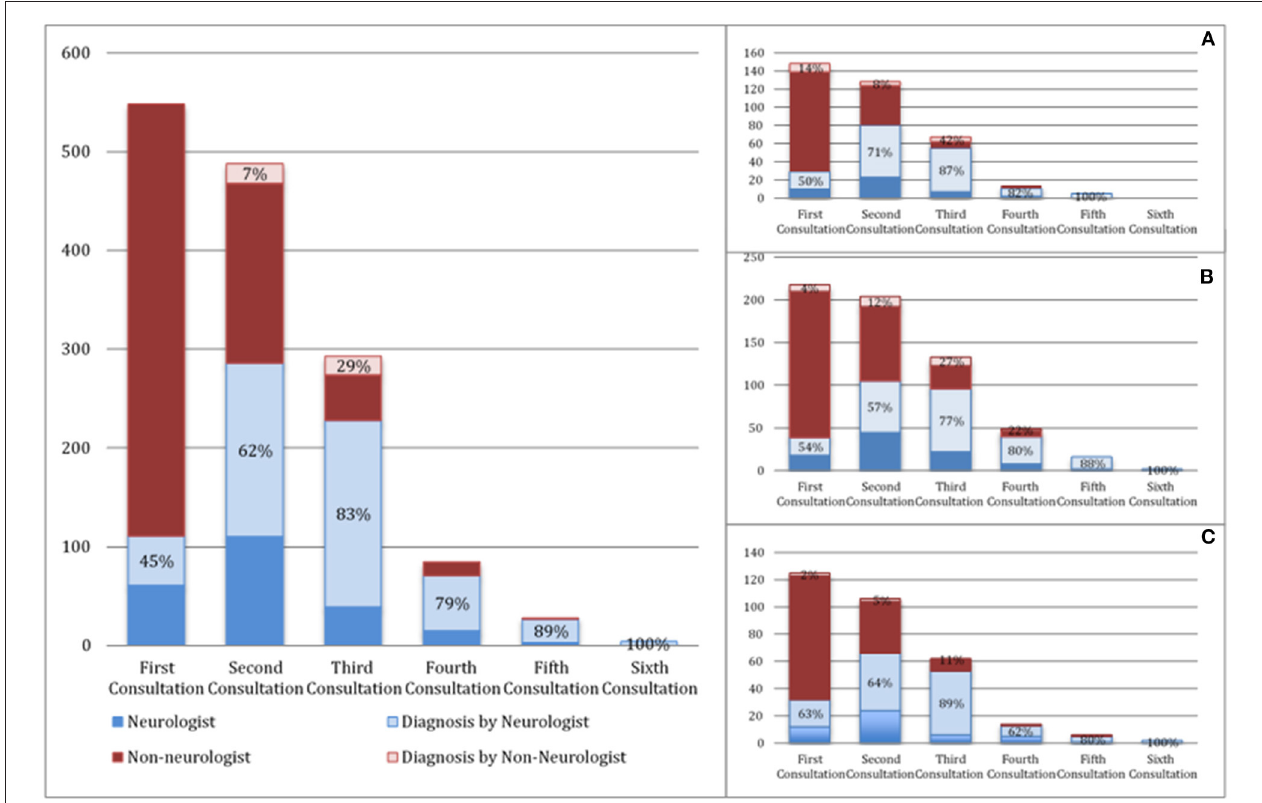
FIGURE 1 | Diagnostic pathway of ALS patients ( A —upper limbs onset, B —lower limbs onset, C —bulbar-onset). The proportion of neurologists (light blue) and non-neurologists (light red) who made the diagnosis is represented in percentages.